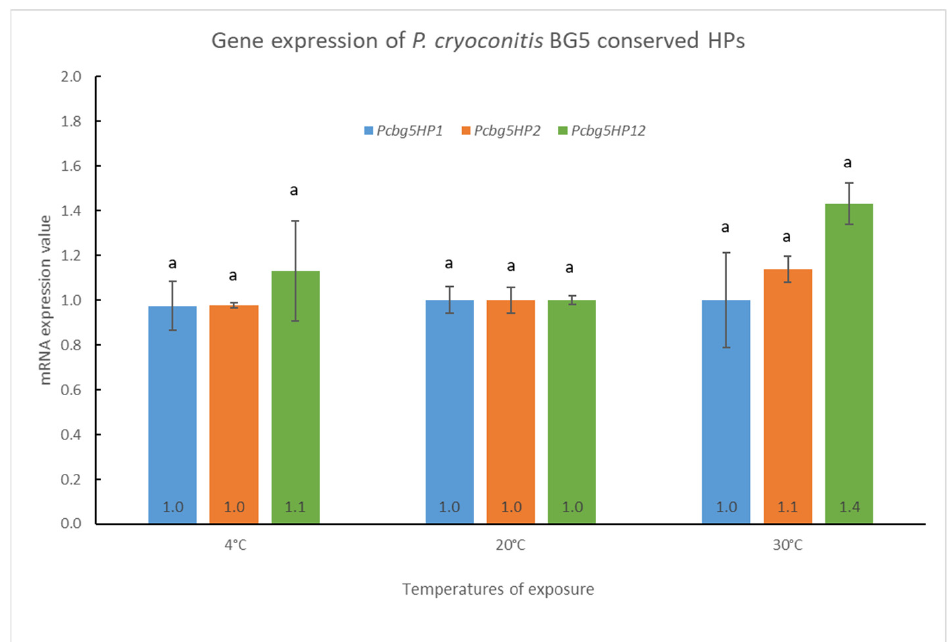
Figure 5. Gene expression analysis of pcbg5hp1 , pcbg5hp2, and pcbg5hp12. Data were representative of three biological replicates and were expressed as the mean ± SD. The letter above columns indicated levels of different significance, p > 0.05. The level of mRNA expression was measured in cells cultured at the indicated growth temperature for 6 h and normalized against 16S rRNA gene (internal control) levels. The mRNA expression value at 20 ◦ C was set to 1 and the other values were normalized against